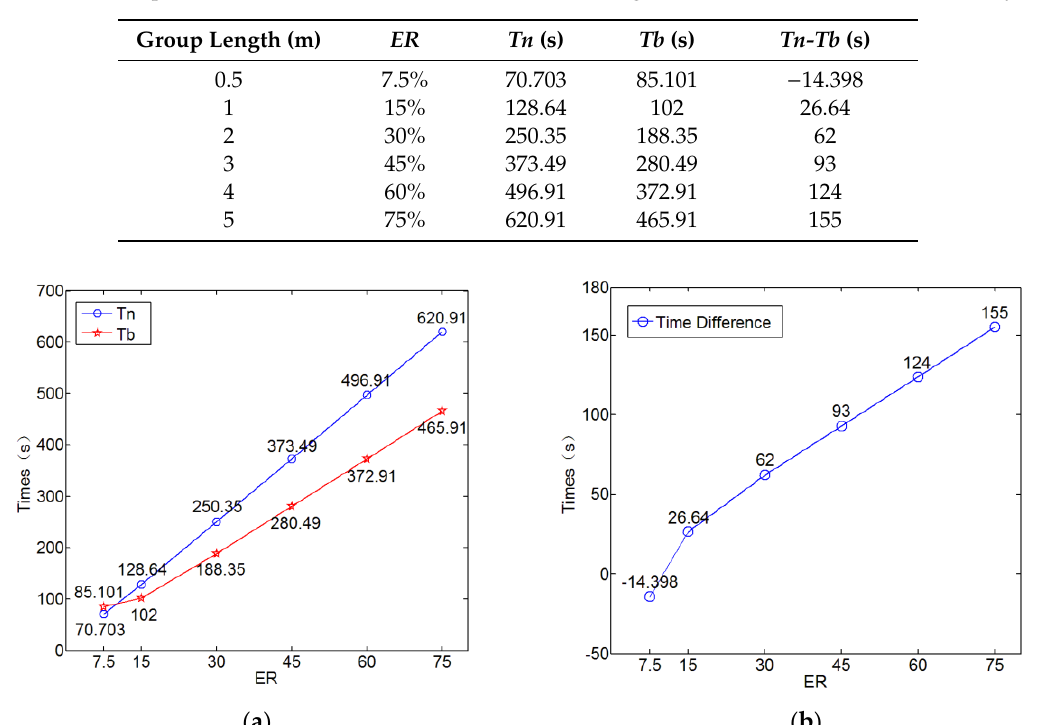
Table 3. Comparison of the total evacuation time of two strategies under different evacuation density Group Length (m)